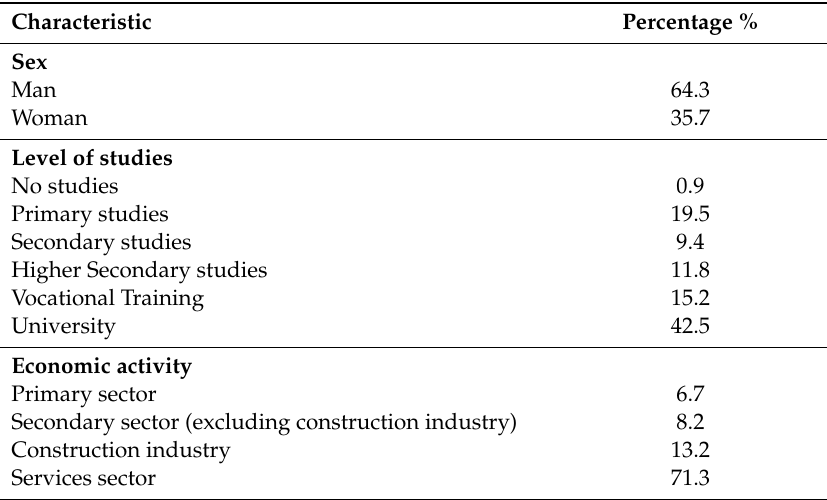
Table 1. Sociodemographic characteristics of the